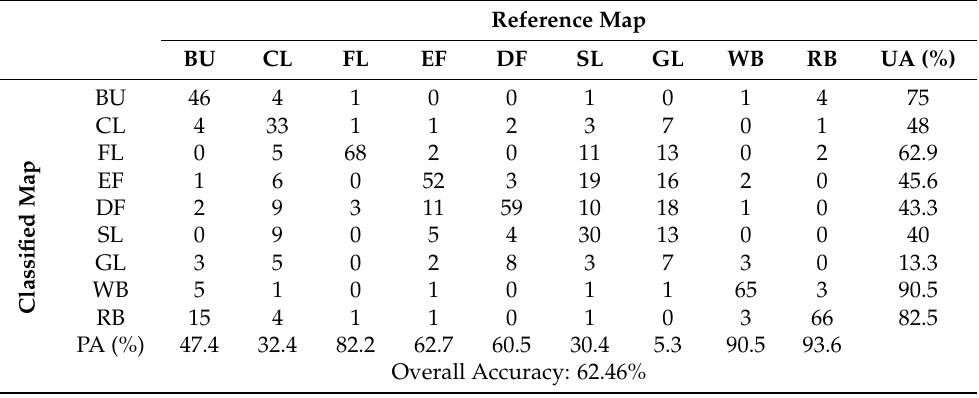
Table 8. Error matrix obtained from the RVM classifier on dataset D-2 for sample size of 175 pixels per class for one of the trials. The number of test samples is at an average of 75 pixels per class. The class-level performance in terms of producer accuracy (PA) and user accuracy (UA) is depicted under PA row and UA column (BU—Built-Up, CL—Cropland, FL—Fallow Land, EF—Evergreen Forest, DF—Deciduous Forest, SL—Shrubland, GL—Grassland, WB—Water Body, RB—River